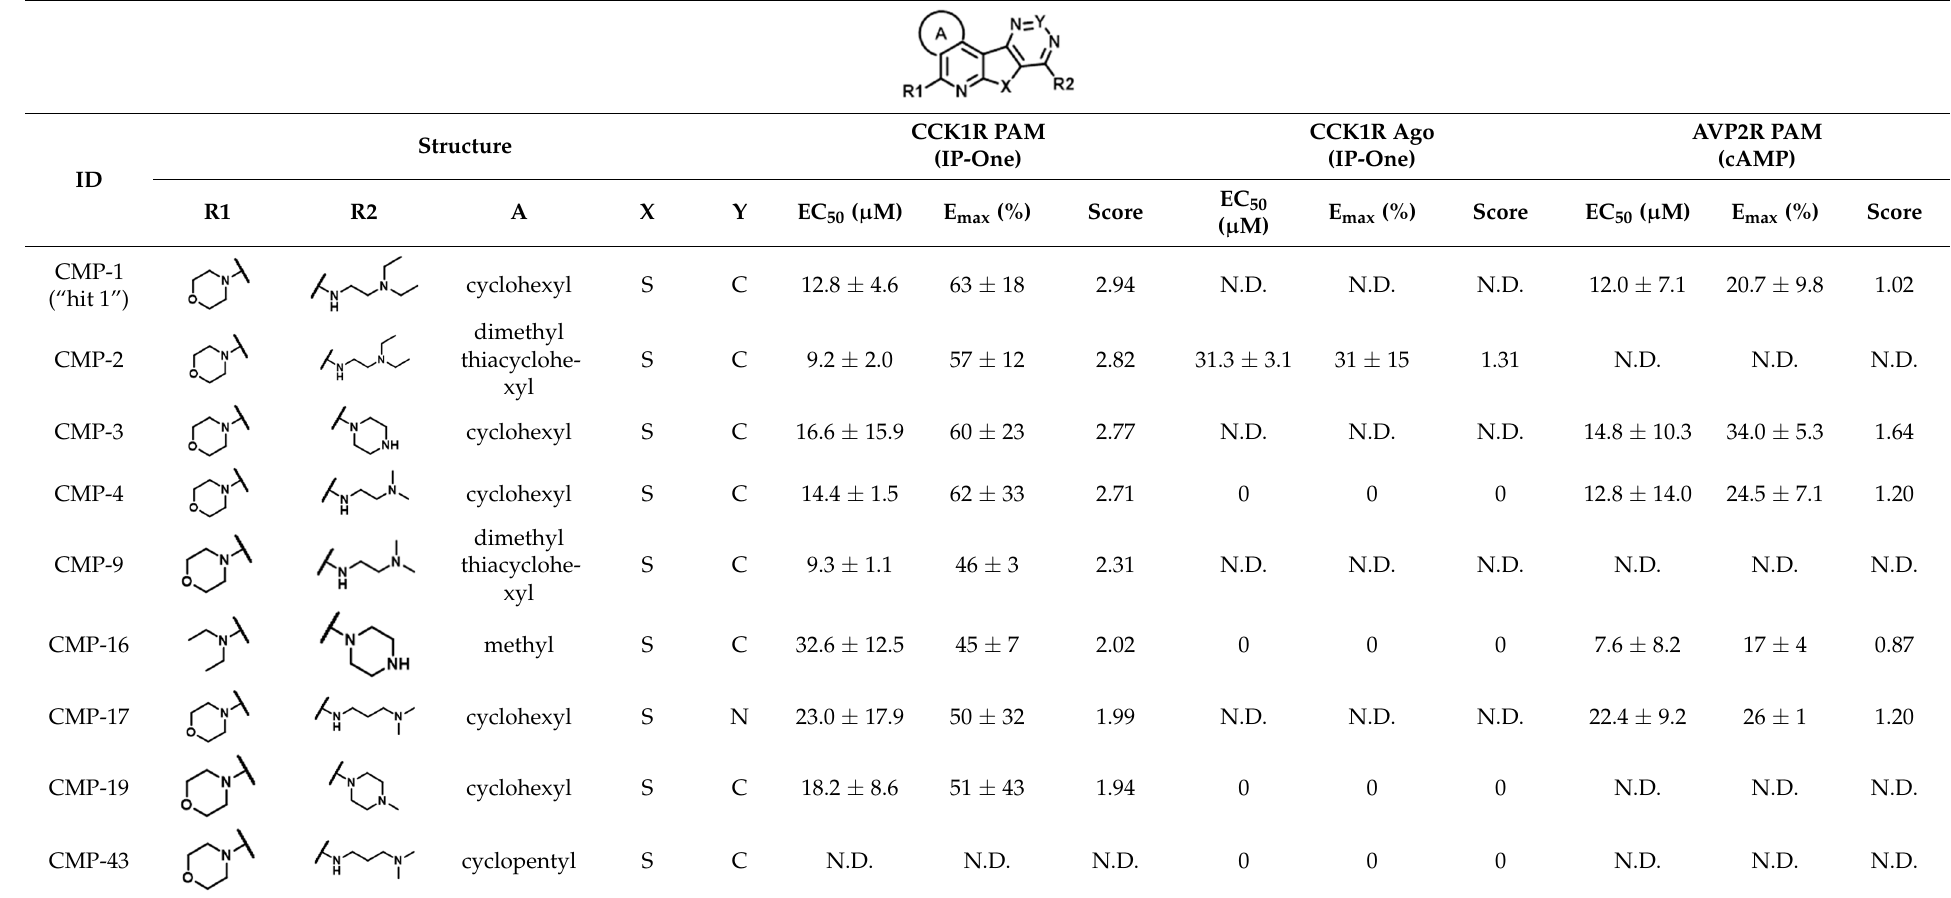
Table 9. Structure–activity studies of eight morpholine and one N -diethyl analogs.